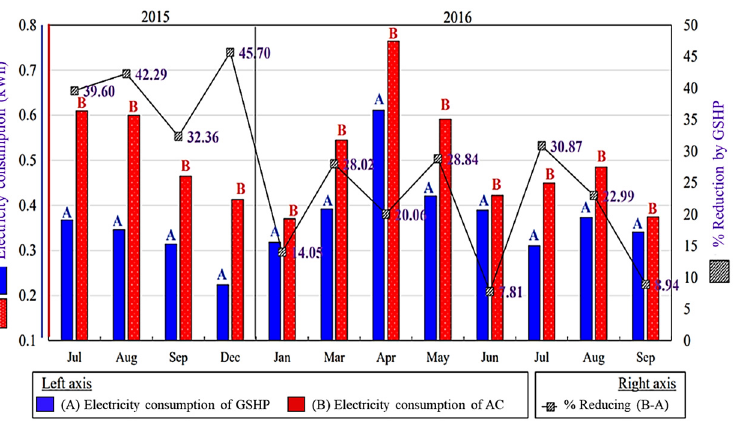
Figure 6. Electricity consumption comparison between the GSHP and the conventional AC when operating at 25 °C recorded from July 2015 to September 2016 in the experimental room (obtained from the report by Chokchai et al. [27]).